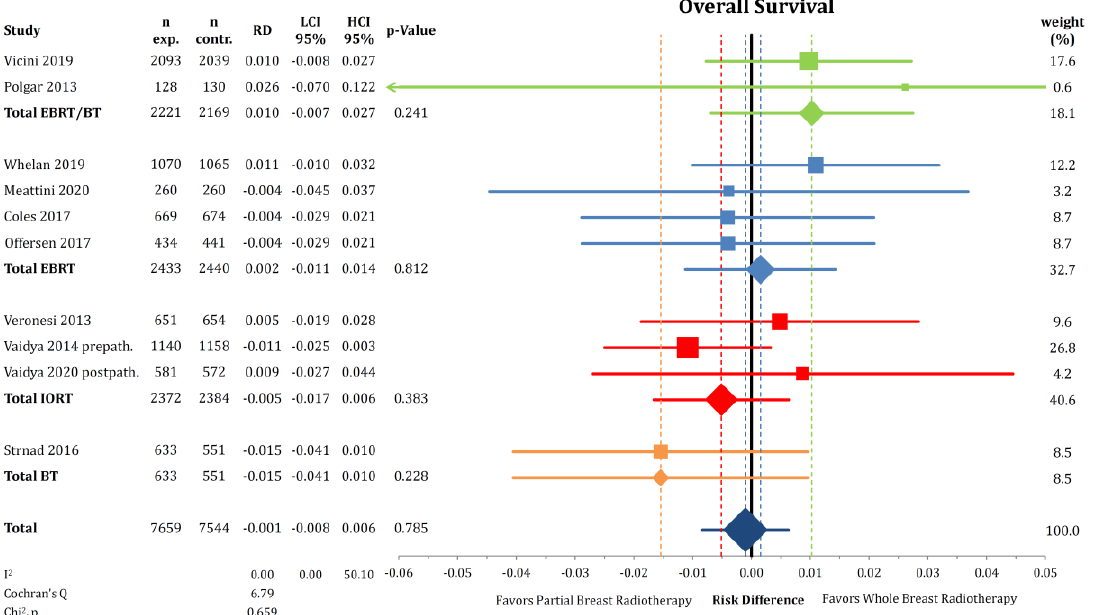
Figure 3. Comparison of overall survival by risk difference between partial- and whole breast radiation using a forest plot and the inverse variance heterogeneity model. Trials are grouped by radiation technique. Quadrats and diamonds represent individual trials and pooled effect sizes with corresponding 95% confidence intervals.